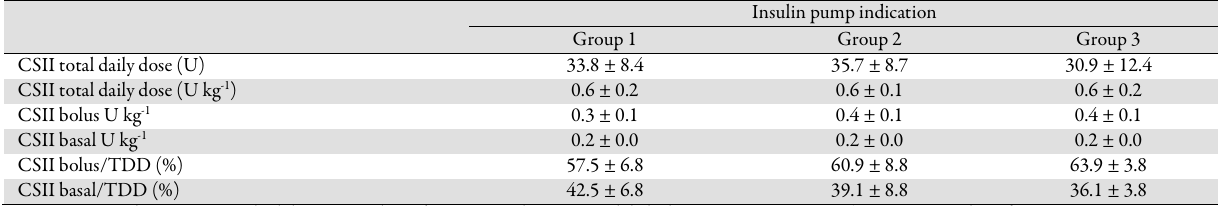
Table 2.CSII insulin doses according to insulin pump